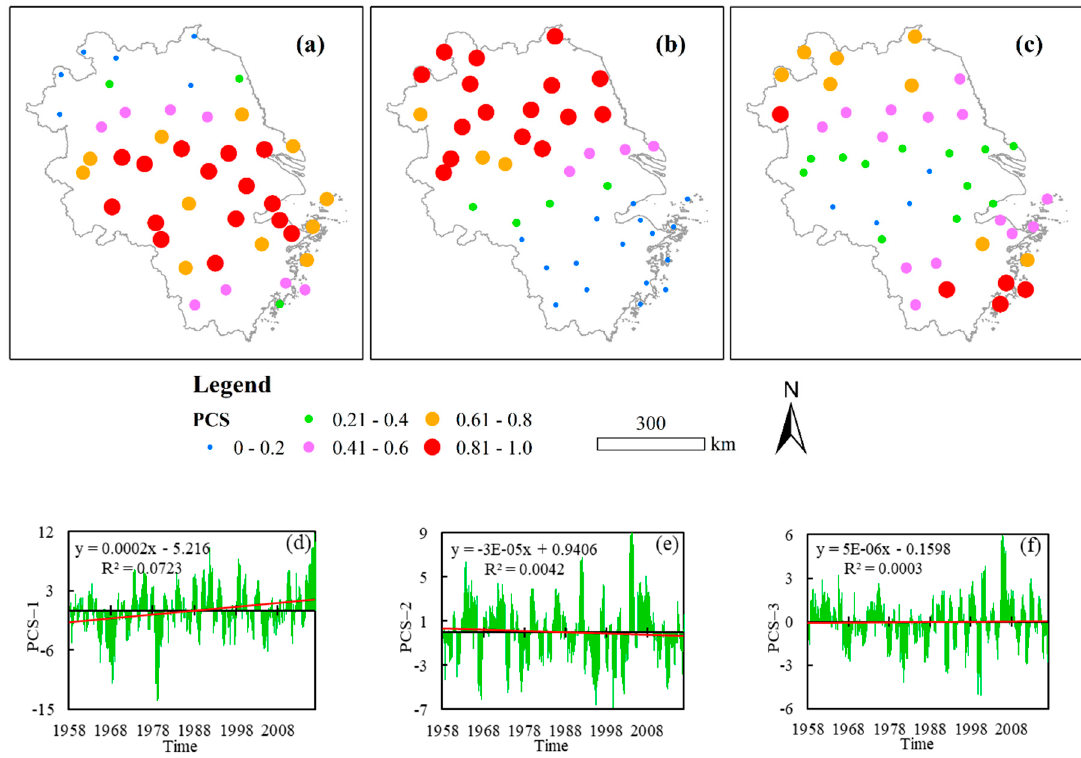
Figure 6. Spatial and temporal patterns of the first three rotated principal components of SPI-12 ( a – c first three rotated loading patterns of the principal components, d – f time series of the corresponding rotated principal component scores (PCS)).